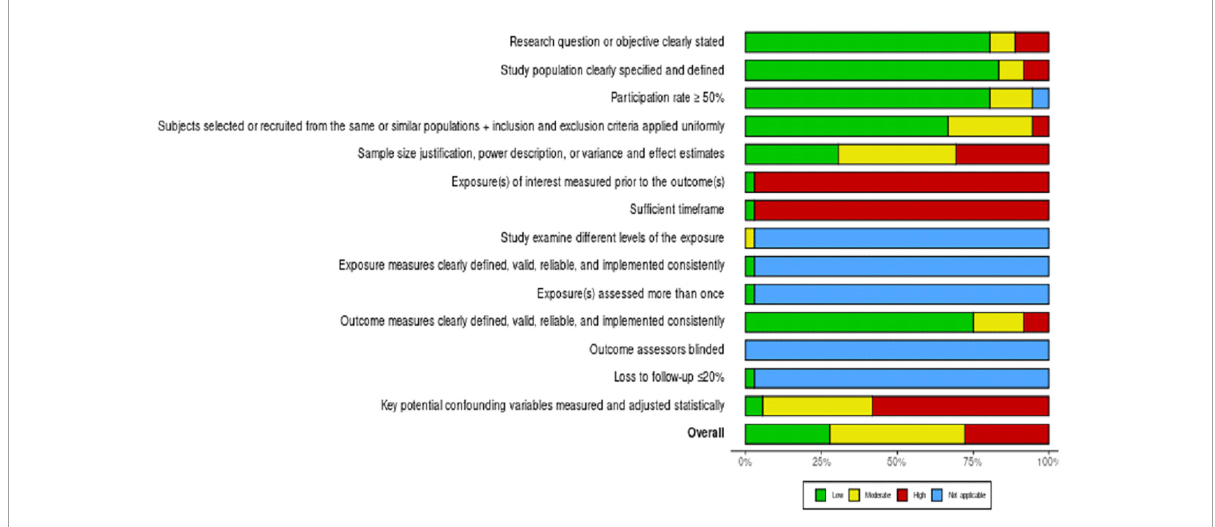
FIGURE3 Overall risk of bias on the National Institutes of Health Quality Assessment Tool for Observational Cohort and Cross-Sectional Studies